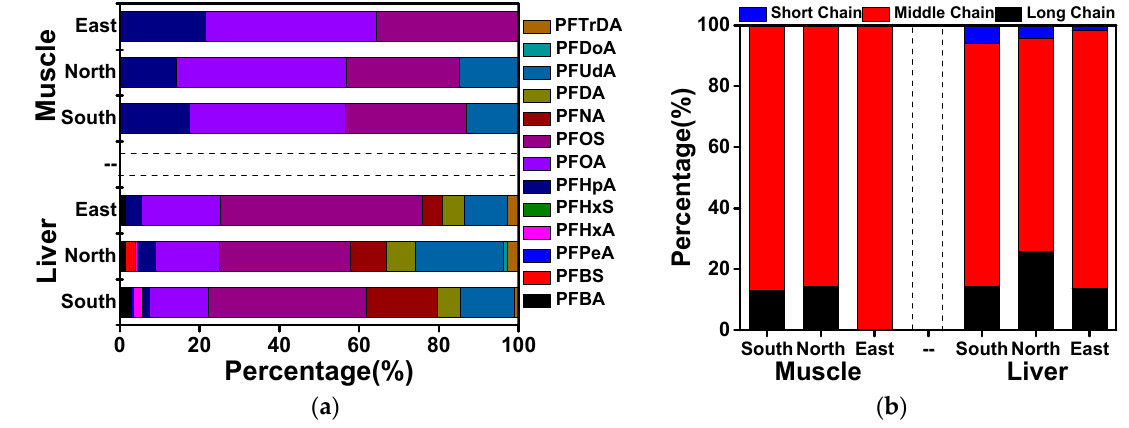
Figure 3. Composition profiles in muscle and liver samples of southern, northern and eastern